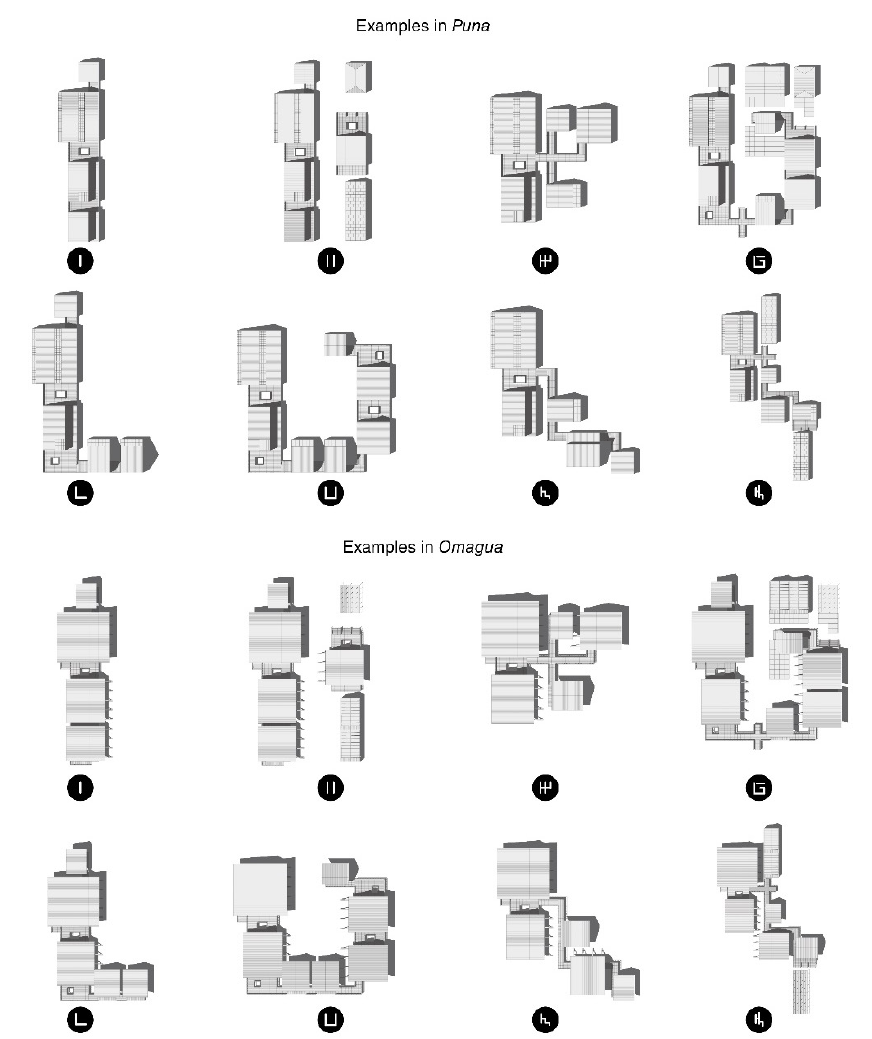
Figure 15. Possible configurations of future tambos (source: